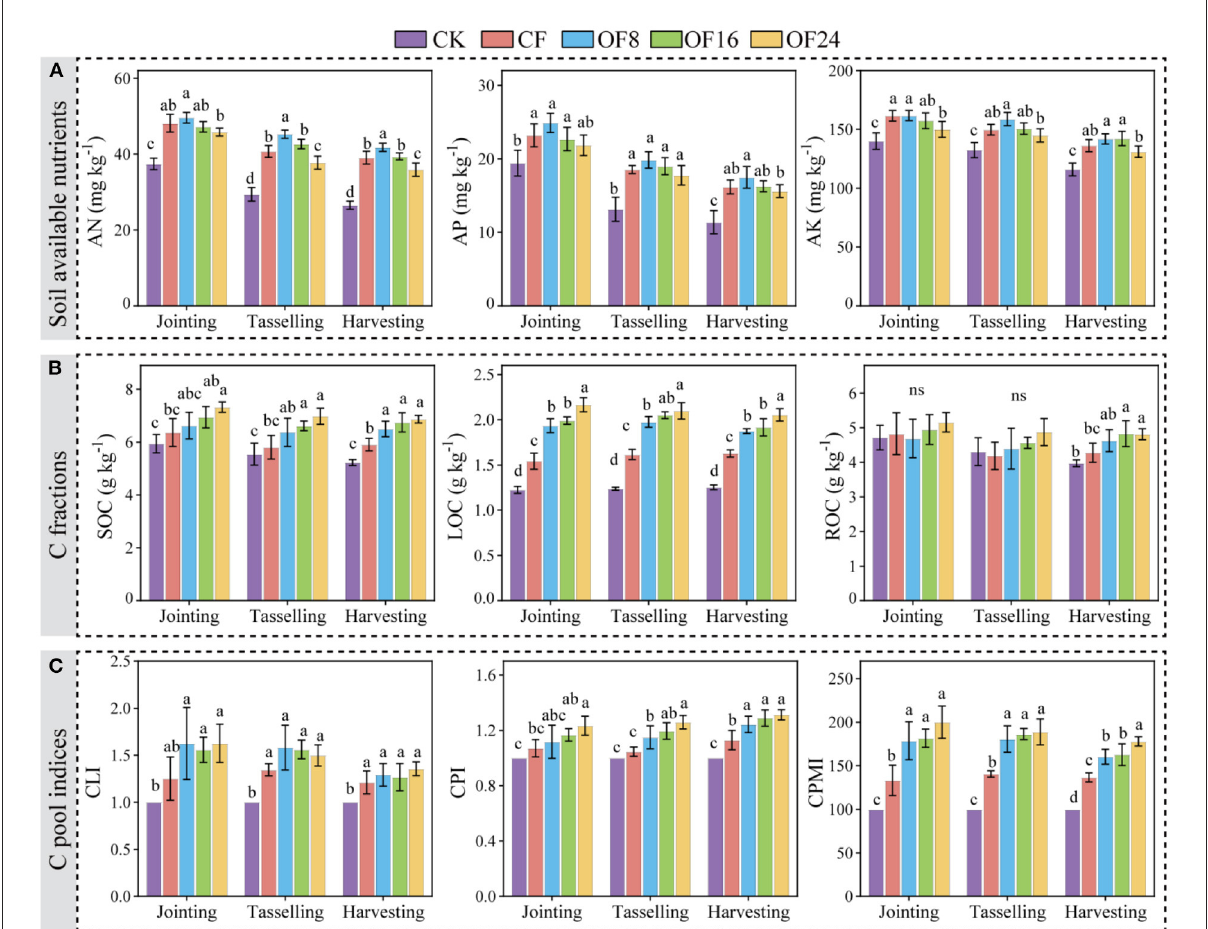
FIGURE2 Effects of different treatments on soil available nutrients (A) , C fractions (B) , and C pool indices (C) at jointing, tasselling, and harvesting stages of maize. The error bars show the standard deviation of the mean of each treatment ( n = 3). Different lowercase letters represent significant differences at the level of p < 0.05. Soil available nutrients include available nitrogen (AN), available phosphorus (AP), and soil available potassium (AK). C fractions include soil organic carbon (SOC), recalcitrant organic carbon (ROC), and labile organic carbon (LOC). C pool indices